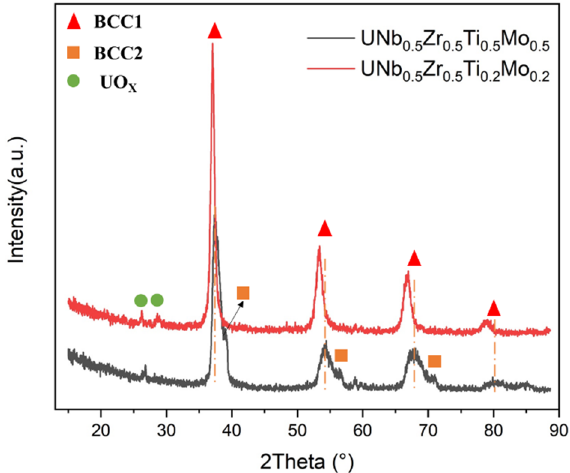
Figure 9. ( a ) δ - Δ H and ( b ) δ - Ω distribution map of U-Nb-Zr-Ti-Mo HEAs. The phase composition and microstructure of the five-element DUHEA were inves- tigated. Figure 10 shows the XRD data on the UNb 0.5 Zr 0.5 Ti x Mo x (x = 0.2, 0.5) HEA. UNb 0.5 Zr 0.5 Ti 0.2 Mo 0.2 was composed of a single BCC structure and UNb 0.5 Zr 0.5 Ti 0.5 Mo 0.5 formed two BCC structures. The addition of Ti and Mo contributed to the formation of BCC2. In addition, when the concentration of Ti and Mo increased, the diffraction peaks were shifted to higher angles, indicating a decrease in the lattice constants. Moreover, the diffraction peaks became broader with the increase in the Ti and Mo contents, indicating grain refinement [33].